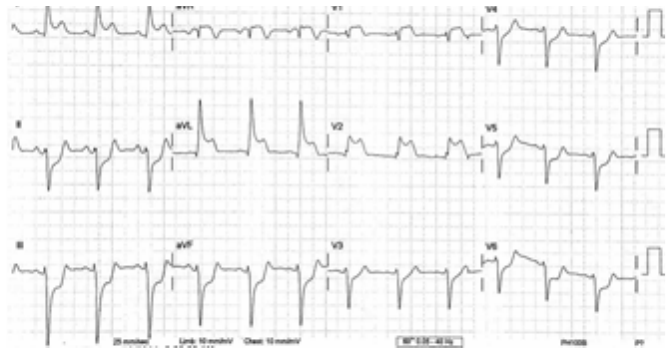
Figure 1. Initial emergency medical services electrocardiogram showing ST-segment elevations across precordial leads consistent with anterior ST-elevation myocardial infarction with reciprocal changes.